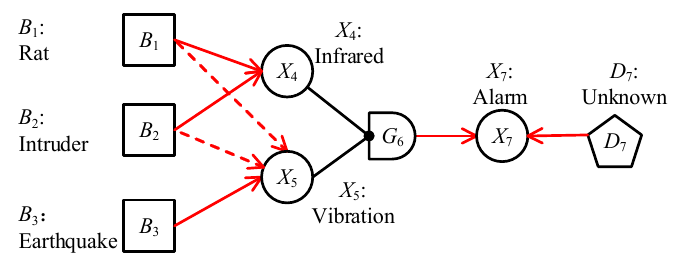
Figure 1. DUCG example.